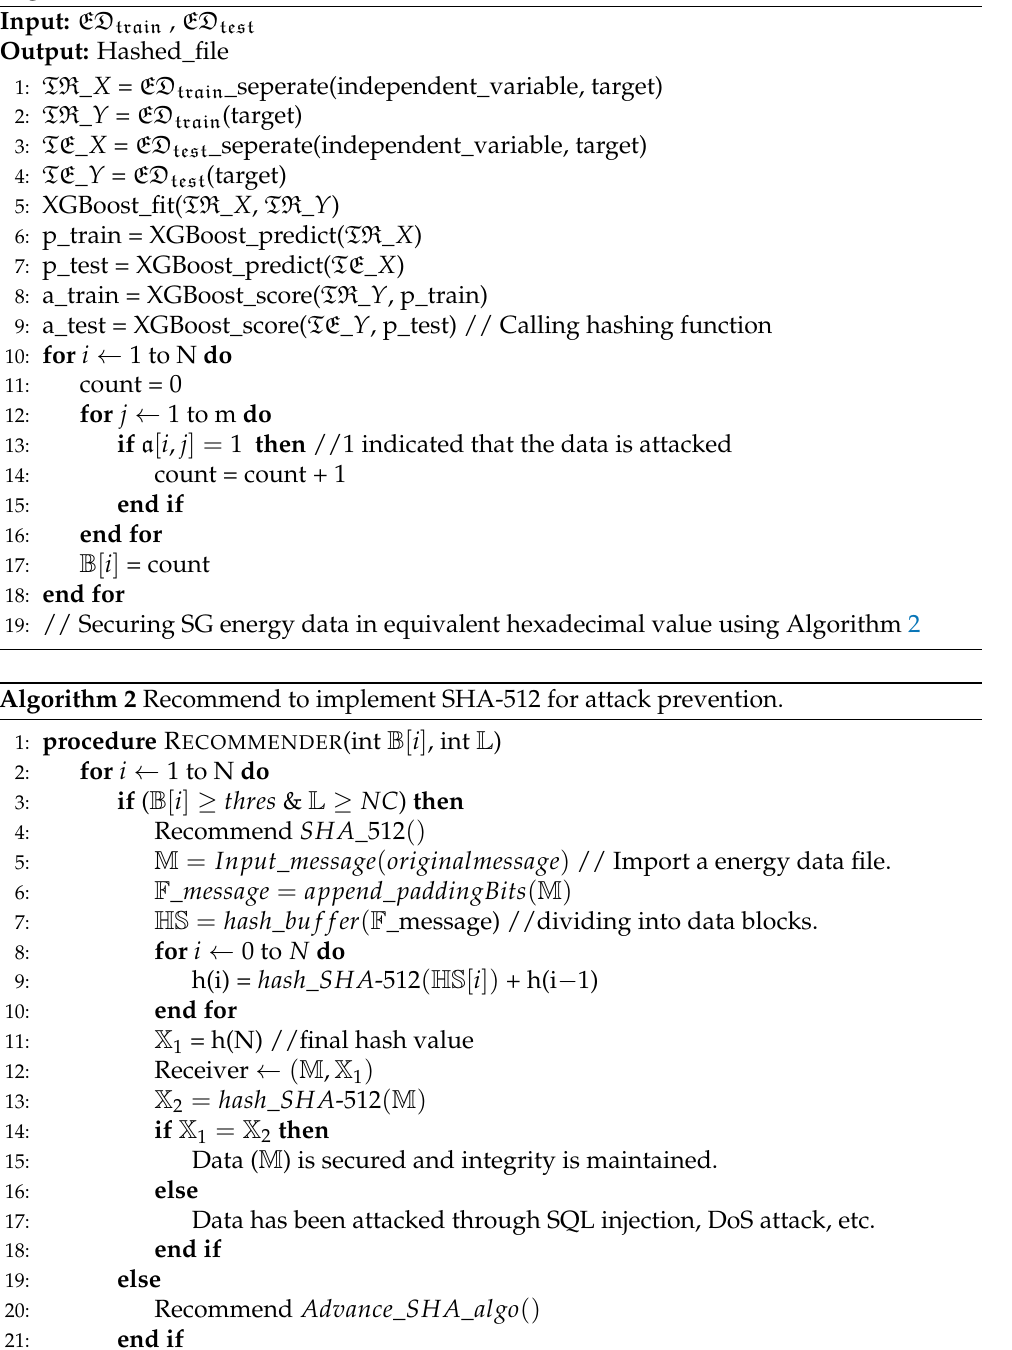
Algorithm 1 XGBoost-based attack detection.